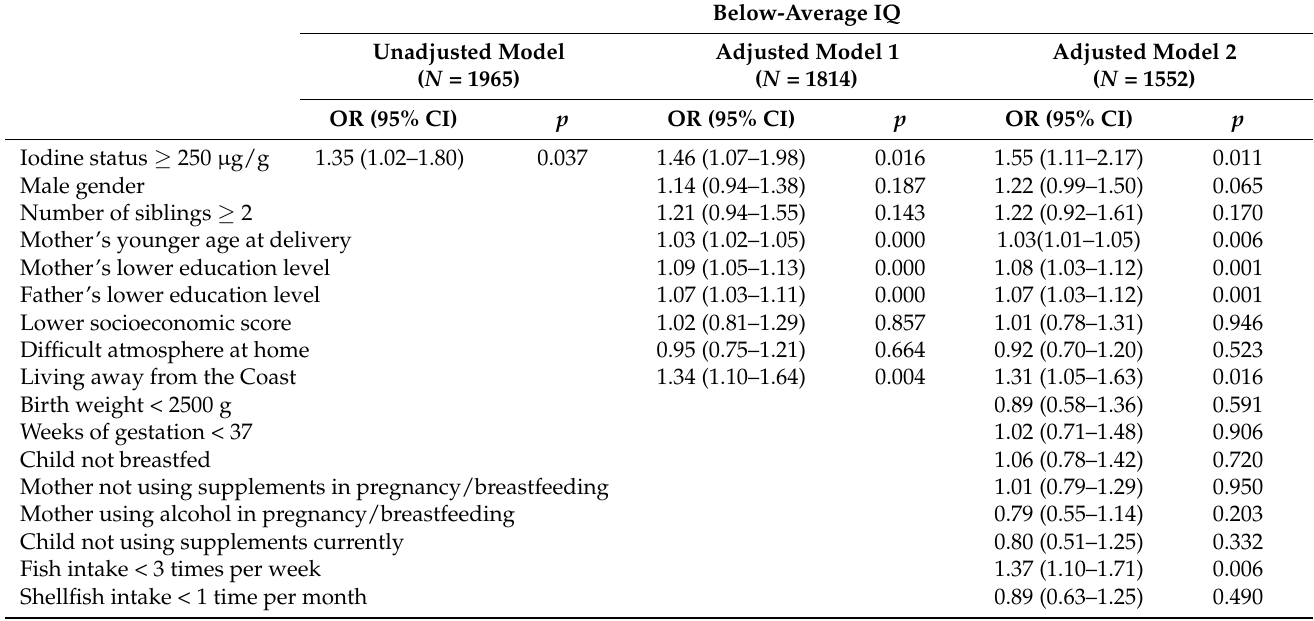
Table 2. Odds of lower IQ for high urinary iodine-to-creatinine ratio, unadjusted and adjusted for possible